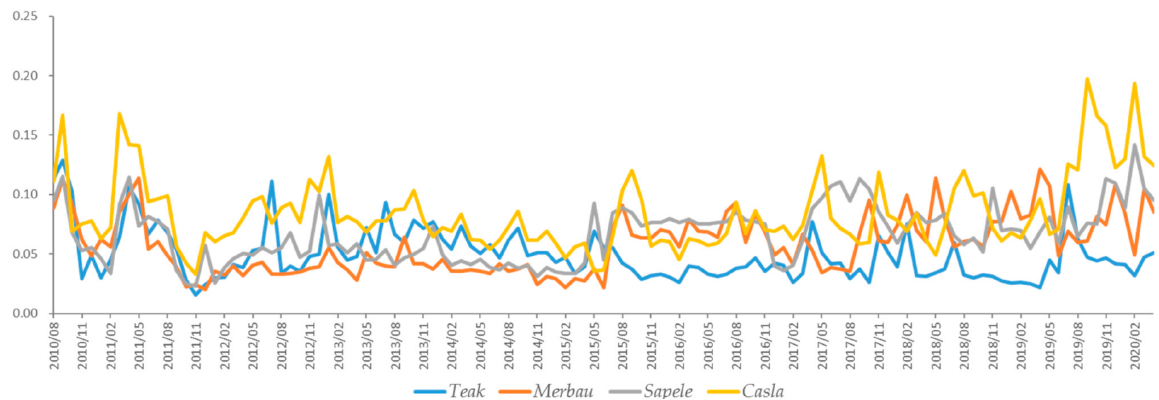
Figure 1. The monthly price volatility ratio of major hardwood lumber imported by